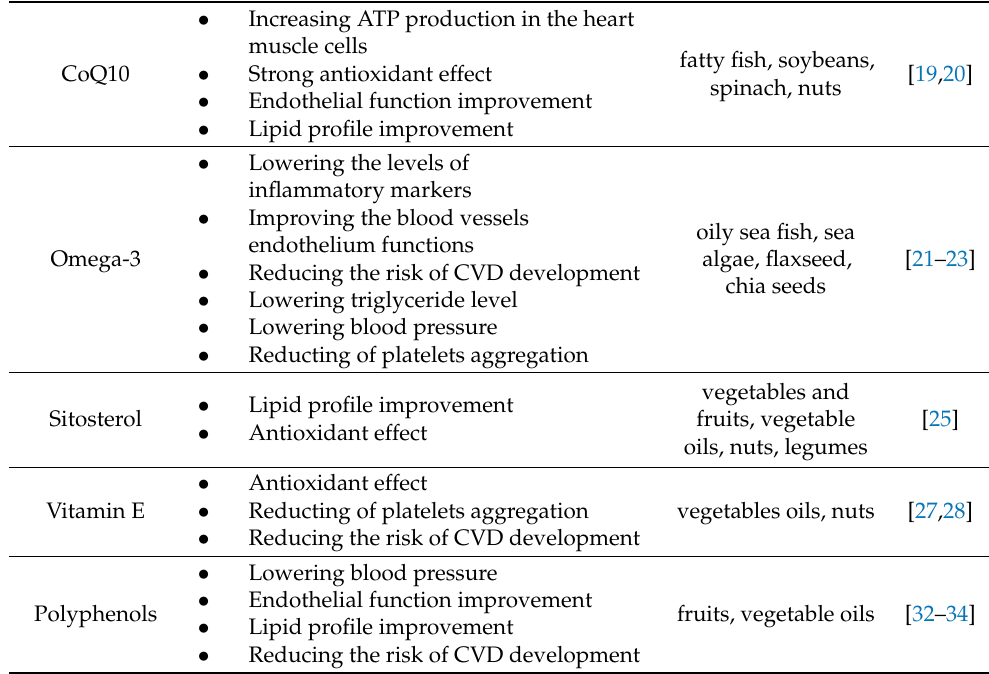
Table 1. Selected cardioprotective food